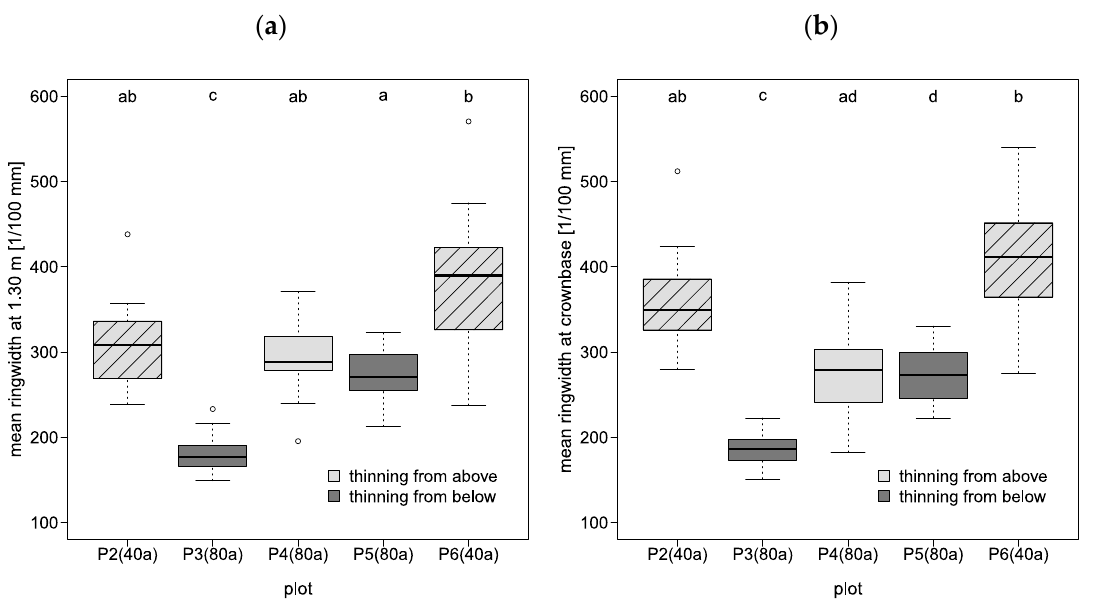
Figure 3. Range of mean ring width [1/100 mm] at ( a ) DBH and at ( b ) CBH for the investigated five plots with different silvicultural treatment (light gray: TFA, dark gray: TFB; hatched: age group 40, not hatched: age group 80). Letters (a–d) indicate significant differences between the plots at p < 0.05 (non-parametric, Kruskal–Wallis test with Bonferroni correction).